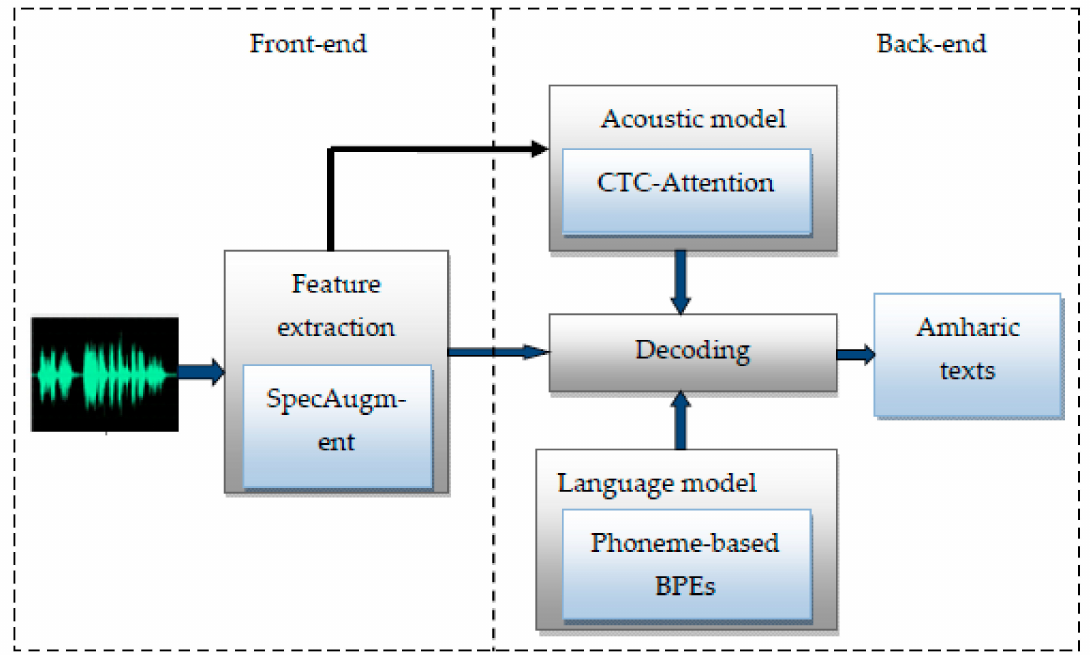
Figure 4. The architecture of the new proposed end‑to‑end Amharic automatic speech recognition (ASR)